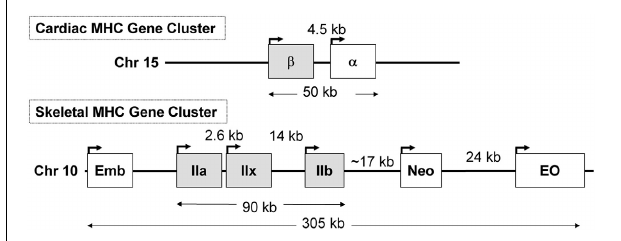
FIGURE 7 | The organization of the sarcomeric myosin heavy chain (MHC) gene family. At least 8 MHC genes are expressed in striated muscle and are found in two clusters: (1) the cardiac MHC gene cluster on rat chromosome 15, which consists of the type I also called β and the α cardiac MHC genes. Type I is the slow MHC expressed in slow skeletal muscle fibers; (2) the skeletal MHC gene cluster on rat chromosome 10, the embryonic (Emb), fast IIa, IIx, IIb, neonatal (Neo) and extraocular (Eo) genes are located in tandem in the order depicted. This MHC gene organization, order, head to tail orientation, and spacing has been conserved through millions of years of evolution and could be of great significance to the way these genes are regulated in response to various stimuli. Human and mouse cardiac MHCs are found on chromosome 14; whereas human skeletal MHCs are found on chromosome 17, and the mouse skeletal MHCs are found on chromosome